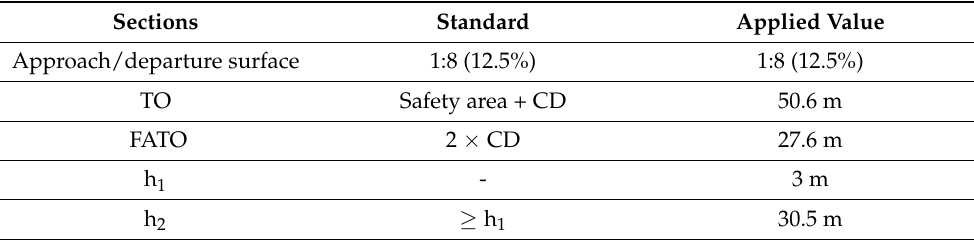
Table 11. The dimensions of the approach/departure surface for the pier topology at the current Gimpo Airport parking lot that comply with the EASA’s new regulations.